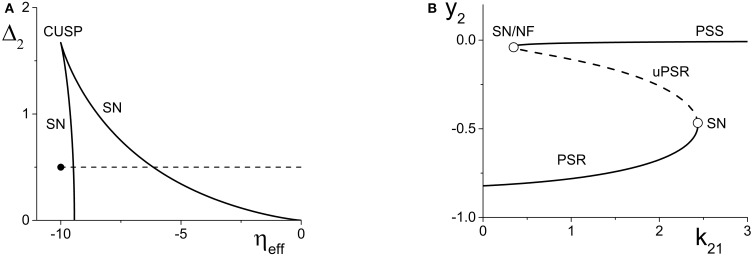
(A) A two-dimensional bifurcation diagram of the excitatorily-coupled response system. The heavy black lines are saddle-node (SN) bifurcation curves, and the solid dot denotes the parameters of the response system when decoupled from the driver. In the cases considered in the main text, the driver causes ηeff to vary along the horizontal dotted line. The parameters are: η1 = −0.2, Δ1 = 0.1, k11 = −2, and k22 = 9. (B) The one-dimensional bifurcation diagram showing the asymptotic values of y2 = Im(z2) vs. k21. Solid and dashed curves indicate stable and unstable equilibria, respectively, corresponding to partially synchronous spiking (PSS) and partially synchronous resting (PSR) states. The parameters are as in (A), with η2 = −10 and Δ2 = 0.5.